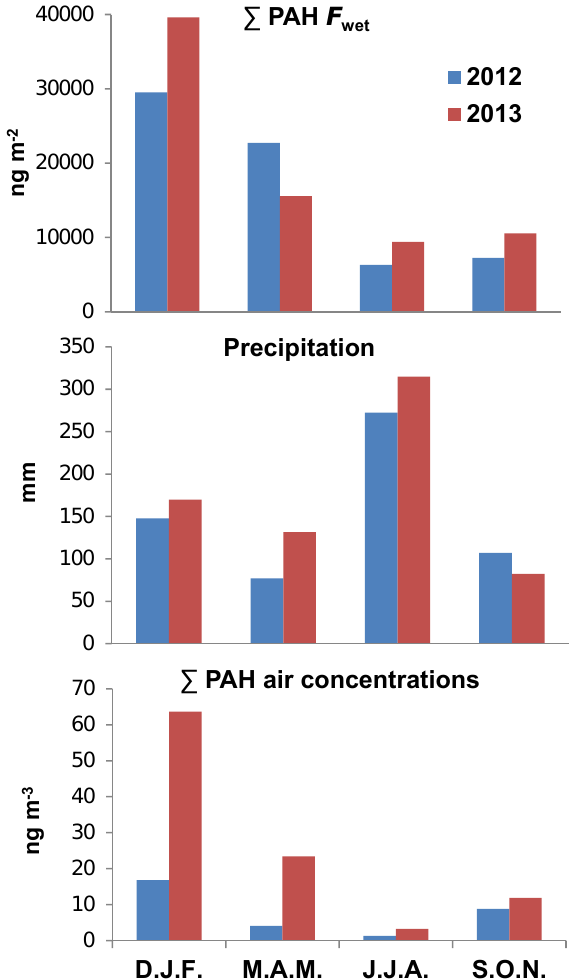
Figure 1. P PAH seasonal fluxes ( F wet ), precipitation amounts, and P PAH median air concentrations in winter (D.J.F.), spring (M.A.M.), summer (J.J.A.), and autumn (S.O.N.) at Košetice.